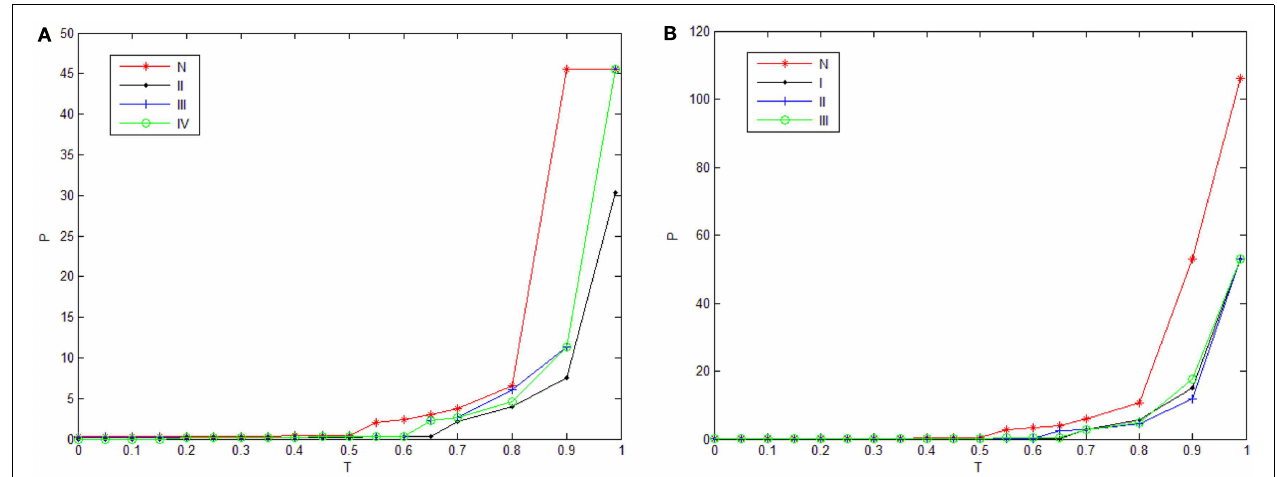
FIGURE 1 | Plots of the percentage of failure nodes of the network P versus threshold values used to construct mutual information networks. The red, black, blue, and green curves correspond to the cases of the normal state, stage II, stage III, stage IV respectively. (A) and (B) correspond to glioma and renal cancer.